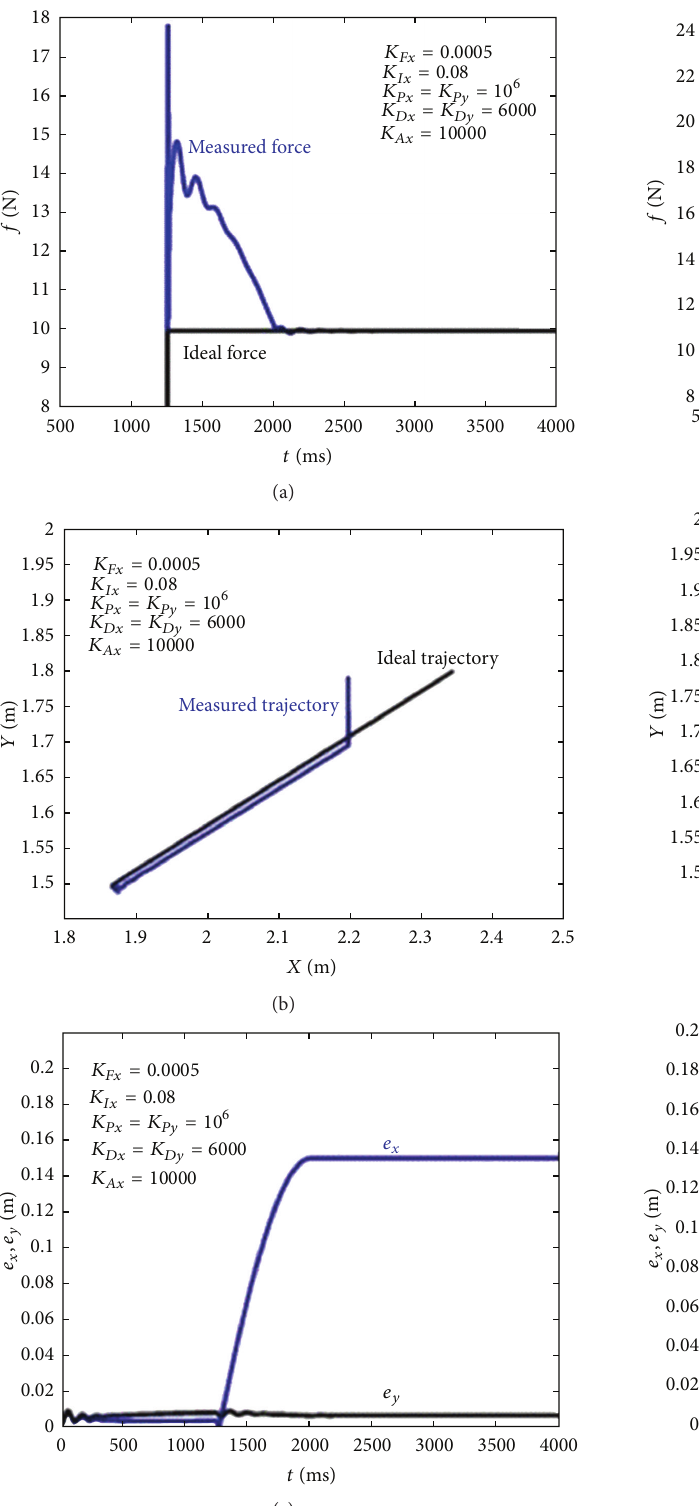
Figure 26: Force (N), position (m), and error position (m) of PI system assuming that 𝐾 𝐴 = 10000 .